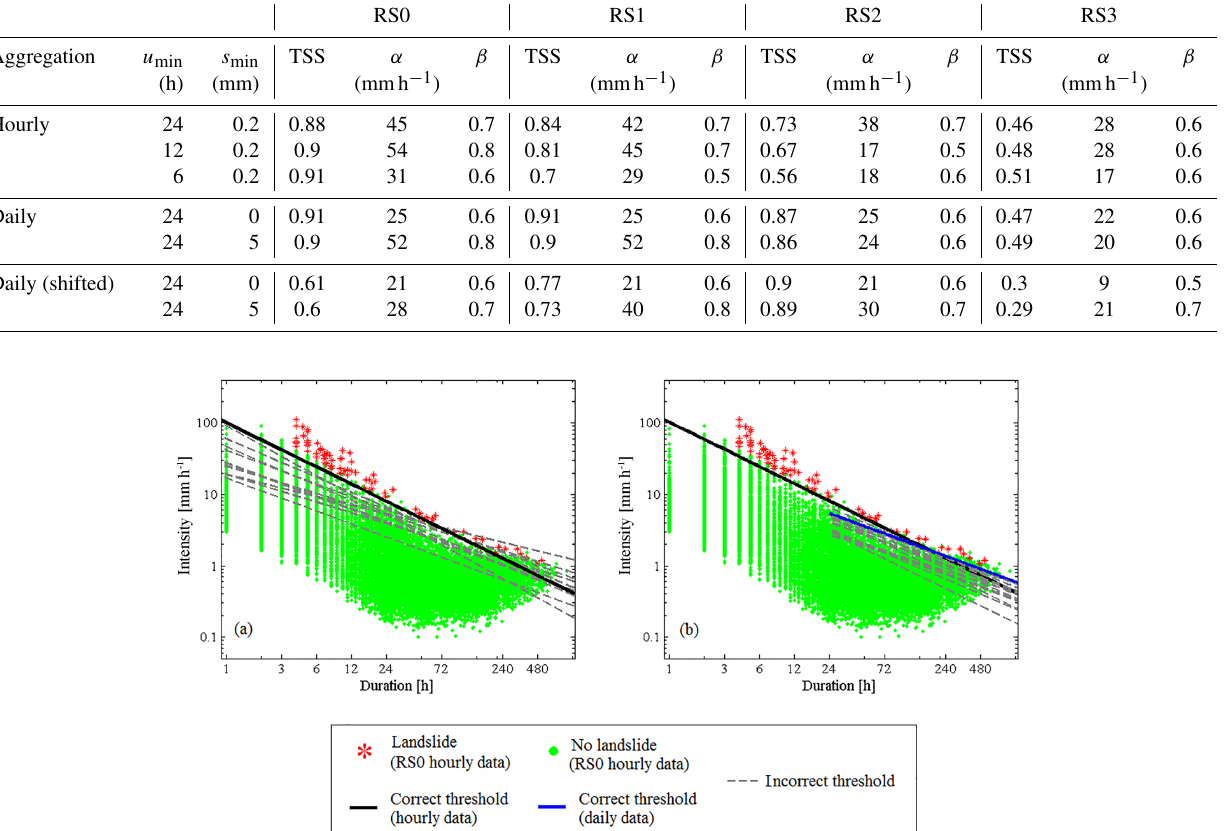
Figure 8. Comparison of thresholds, calibrated in the various scenarios and event identification parameters, with the correct hourly dataset. Thresholds determined with (a) hourly and (b) daily data (both correct and with aggregation shift) are distinguished. Correct thresholds are relative to the following event identification parameters: u min = 24h, s min = 0 . 2mm, and u min = 1day, s min = 0mm, for hourly and daily data, respectively. These plots are representative of how thresholds calibrated with uncertain information of triggering rainfall data may perform in early warning systems that use high-quality rainfall and landslide